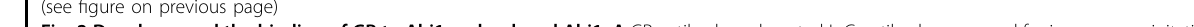
Fig. 2 Dex decreased the binding of GR to Ahi1 and reduced Ahi1. A GR antibody and control IgG antibody were used for immunoprecipitation of the mouse hypothalamic tissue. GR-interacting proteins were examined by Western blotting with anti-Ahi1, anti-Hap1, and anti-GR. The representative images were shown. B After Dex treatment for 21 days, the hypothalamic tissues were collected for the immunoprecipitation by anti-GR or IgG. Ahi1 was examined by western blotting. The binding of GR to Ahi1 under Dex treatment was analyzed by using the ratio of immunoprecipitated Ahi1 to IgG. N = 4 mouse brains per group. P = 0.0028 versus Control (Con). C PC12 cells were treated with Dex (20 μ M) with or without mifepristone (20 μ M) for 72h and then Ahi1 and GR were examined by western blotting. Quantitative analysis of Ahi1 and GR levels was further performed (Ahi1: F (1,12) = 30.07, *** P < 0.0001; GR: F (1,12) = 16.99, ** P = 0.0014). n = 4 cell samples. D PC12 cells were treated with Dex (20 μ M) and MG132 (0.5 μ M) for different times (0 – 60h). Ahi1 and GR were examined by western blotting ( n = 3 per group). E GR knockdown by GR-siRNA was performed in PC12 cells. Ahi1 and GR were examined by western blotting at 48h after transfection and quanti fi ed. ( t (6) = 3.969, * P = 0.0166, n = 4 cell